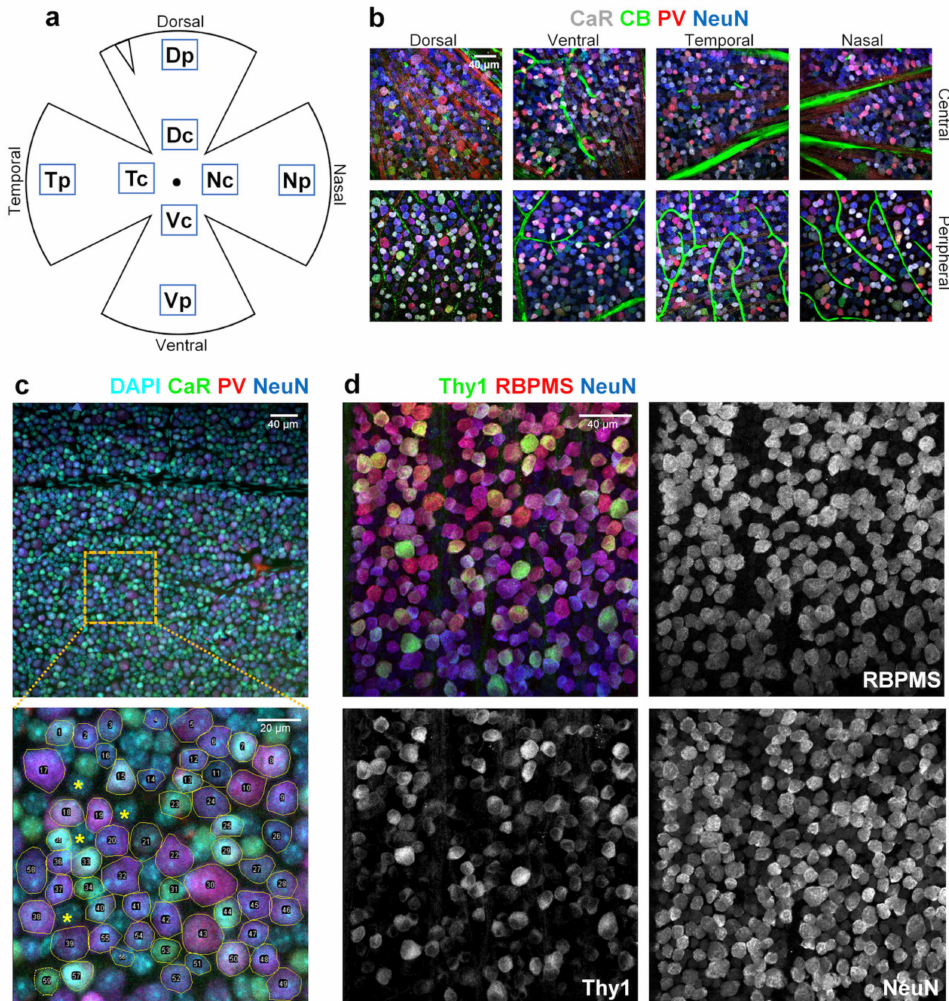
Figure 1. Measurement of Ca 2 + -bu ff er protein (CaBP) expression levels in retinal samples. ( a ) Schematic drawing of approximate locations of selected retinal areas (V—Ventral, N—nasal, D—Dorsal, T—Temporal; c—central, p—peripheral). ( b ) Representative retinal areas with all utilized cellular markers. ( c , d ) Whereas DAPI (4 (cid:48) ,6-diamidino-2-phenylindole) labels all cellular nuclei and therefore marks both neuronal and non-neuronal cells simultaneously, neuronal nuclei antibody (NeuN) stains neurons exclusively. In addition, NeuN provides brighter staining for retinal ganglion cells (RGCs), while at the same time, displaced amacrine cells (ACs) appear dimmer, this distinction is visualized using RBPMS antibody (RNA-binding protein with multiple splicing) staining on a GCaMP3-Thy1 (THYmocyte di ff erentiation antigen 1) mouse retina. This provides a clear basis for separating ganglion cells (GCs) from displaced ACs, allowing us to disregard ACs in our analysis. A central 100 × 100 µ m homogeneous sub-area was selected from each 20 × scanned and merged stack to measure the expression levels of the three CaBPs. All NeuN + cells were measured for calretinin (CaR), parvalbumin (PV), and calbindin (CB) expression levels (only triple and quadruple labelings were included in the measurements). Cells were numbered using FIJI’s regions of interest (ROI)